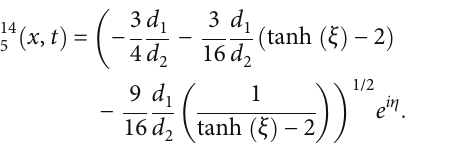
ð x , t Þj for NLFD of order α and for parameters δ 1